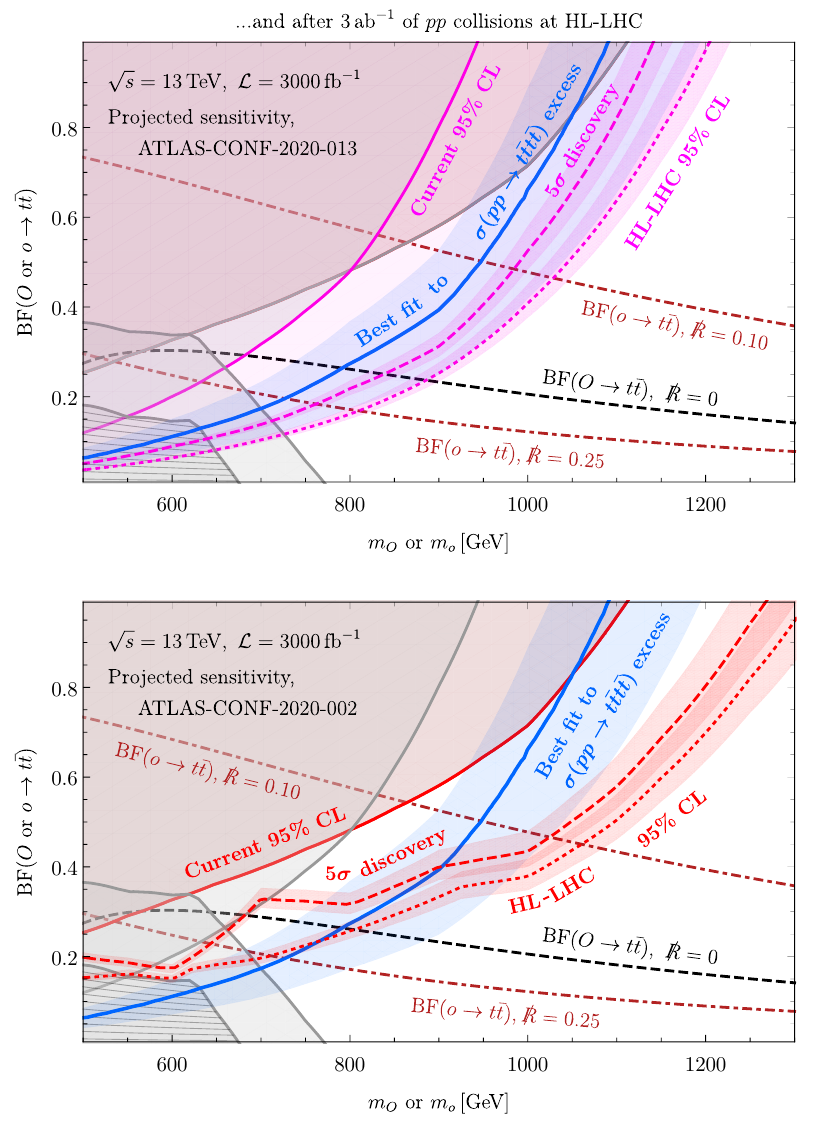
Figure 11 . Maps of color-octet scalar parameter space, based on figure 9, showing projected sensitivity of upgraded high-luminosity Large Hadron Collider (HL-LHC) given planned integrated luminosity L = 3 ab − 1 . Solid contours are carried over from figure 9 and show current limits at 95% CL for comparison. Dashed contours show projected 5 σ (discovery) signal significance for each analysis. Dotted contours show projected exclusion limits at 95% CL. Shaded bands around projection contours indicate uncertainties due to PDF and scale